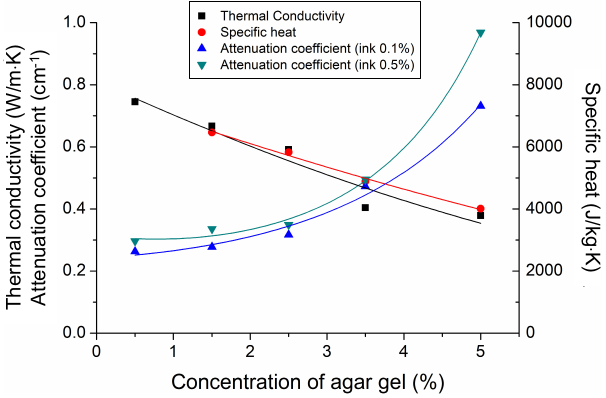
Fig. 4. Measured optical and thermal properties according to agar-gel